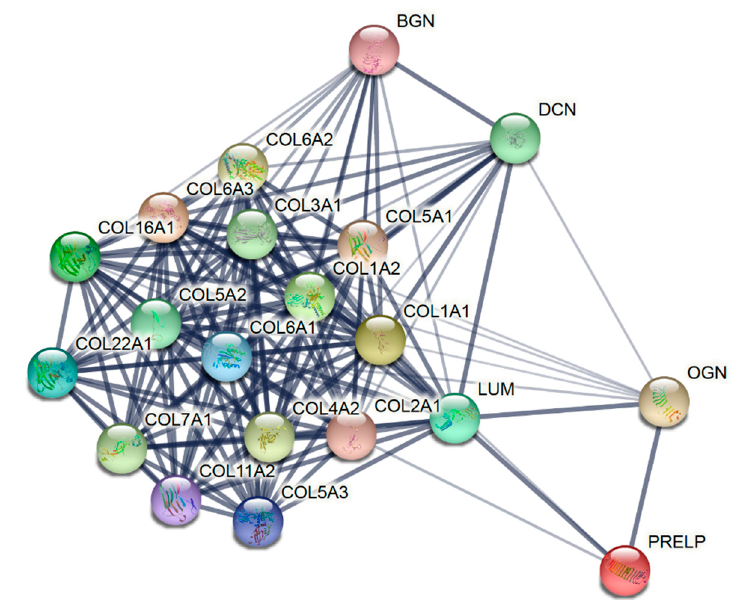
Figure 3. Proteins of the extracellular matrix identified in all lots of the collagen membrane and matrix by high-resolution shotgun proteomic analysis. The STRING network shows that the edges indicate both functional and physical protein associations, with line thickness representing the strength of data support.